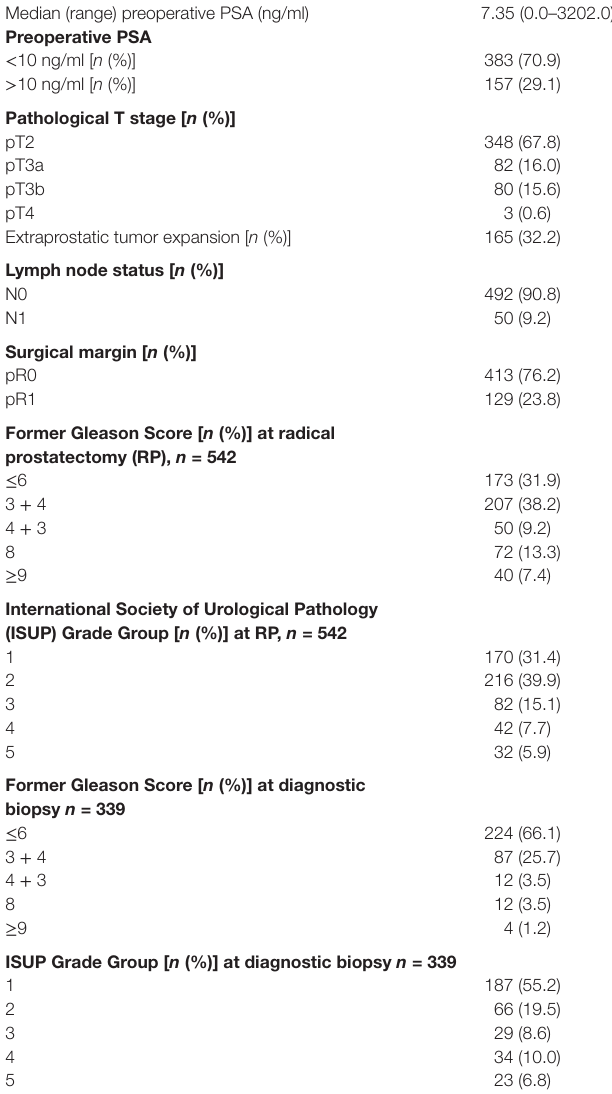
Table 2 | Association between different grading systems at RP or diagnostic biopsies and frequency of biochemical recurrence (BR).